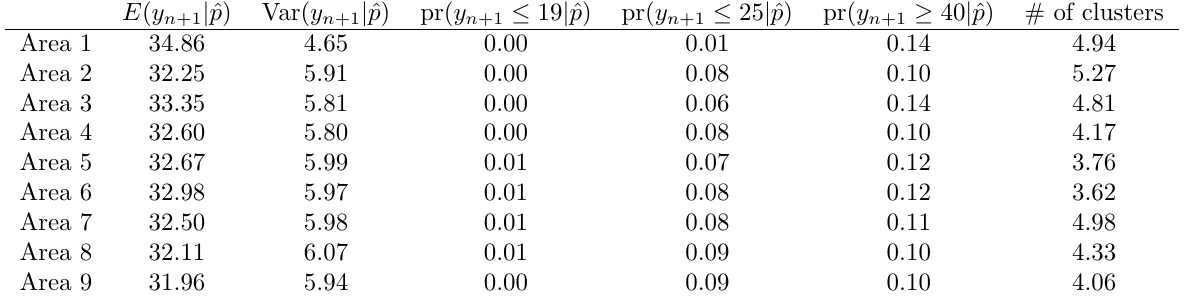
Posterior summaries in the nine different administratives areas of the municipality of Milan. Posterior predictive mean and variance, posterior predictive probability of young and old age at childbirth, averege number of occupied mixture